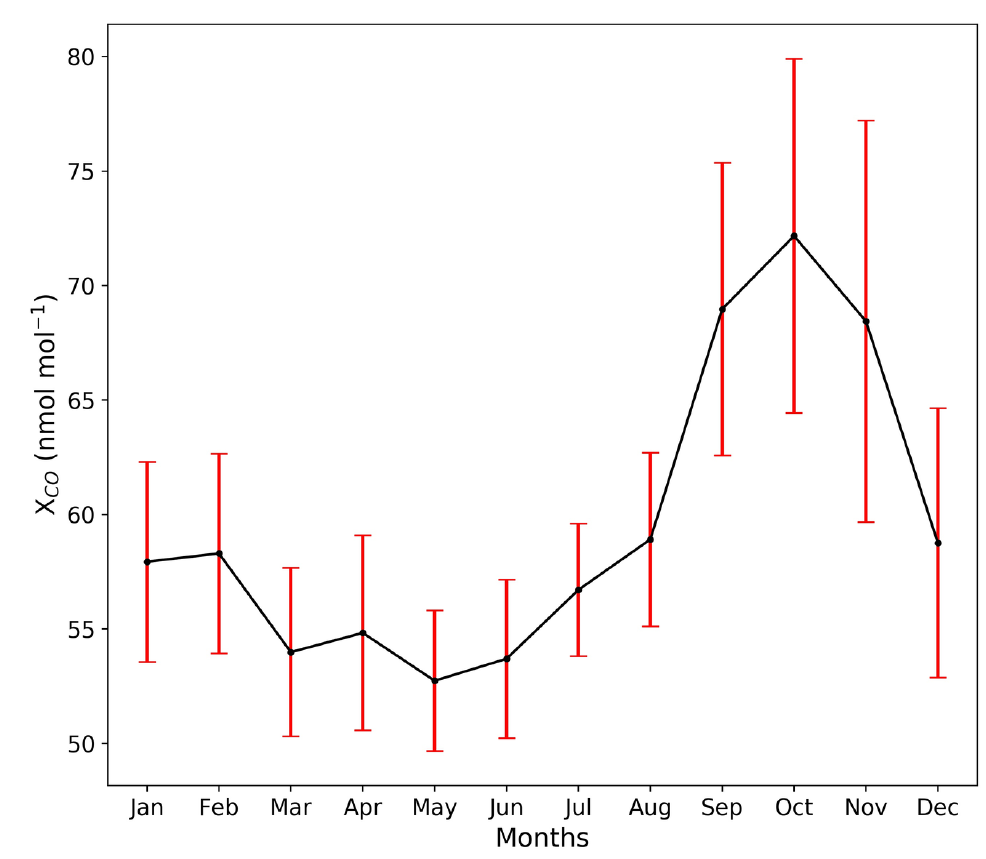
Figure 5. Seasonal cycle of Wollongong column CO data calculated based on the monthly median with Median absolute deviation (MAD) of monthly data (as error bars) from the long term TCCON data record from July 2008 to June